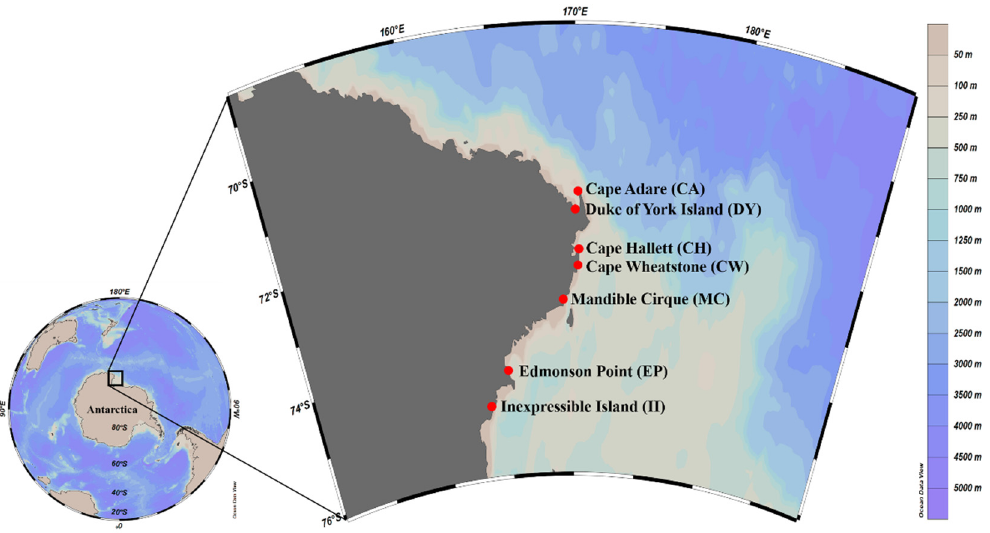
Figure 1. Sample sites for fecal DNA analysis in the Ross Sea region. Map view created by Ocean Data View software version 5.1.7 (Schlitzer, R., Ocean Data View, 2018, odv.awi.de, accessed on 23 December 2021). Table 1. Details of collection of Ad é lie penguin ( Pygoscelis adeliae ) fecal samples used in this study.